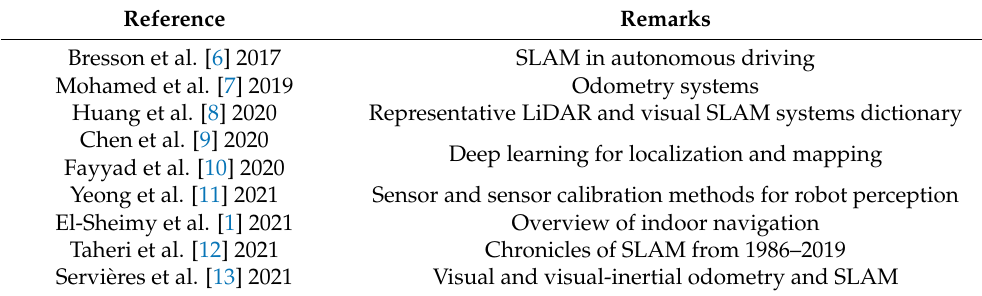
Table 1. Summary of recent reviews on sensors and sensor fusion for SLAM and